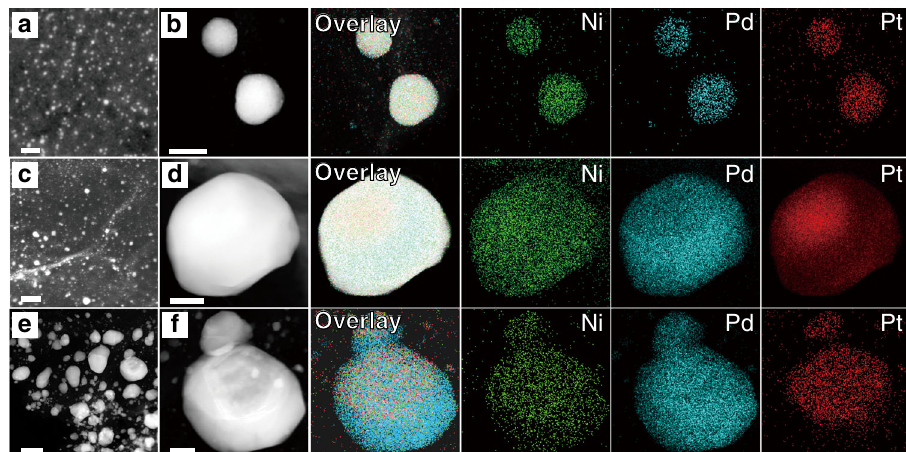
Fig. 4 Synthesis of NiPdPt by different methods. a The STEM image of NiPdPt obtained by FMBP (923 K). b The elemental maps of NiPdPt obtained by FMBP (923 K). c The STEM image of NiPdPt obtained by SMBP (923 K). d The elemental maps of NiPdPt obtained by SMBP. e The STEM image of NiPdPt obtained by FBP. f The elemental maps of NiPdPt obtained by FBP. The loading of HEA-NPs on GO was 3 wt% for a , c , e . The loading of HEA-NPs on GO was 10 wt% for the NiPdPt alloy for elemental maps. Scale bar a : 10 nm, ( b – d , f ): 50 nm, e : 200 nm.